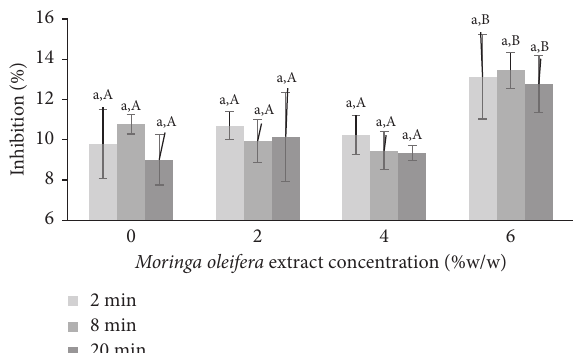
Figure 5: Radical scavenging capacity ( I %) of chocolate alginate beads as affected by MLE concentration (0, 2, 4, and 6% w/w) and hardening time (2, 8, and 20min). Different small letters indicate significant differences among samples of the same concentration, while different capital letters indicate significant differences among samples of the same hardening time at p < 0 .